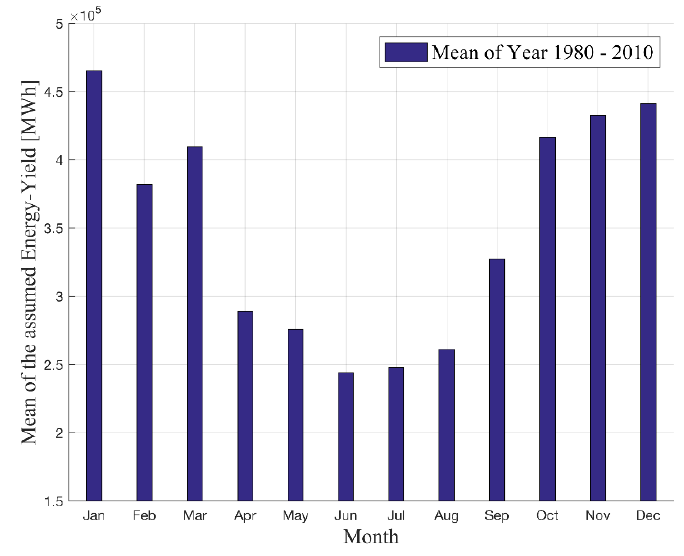
Figure 9. Monthly energy yields of the offshore wind farm as average value over the years 1980 to 2010.